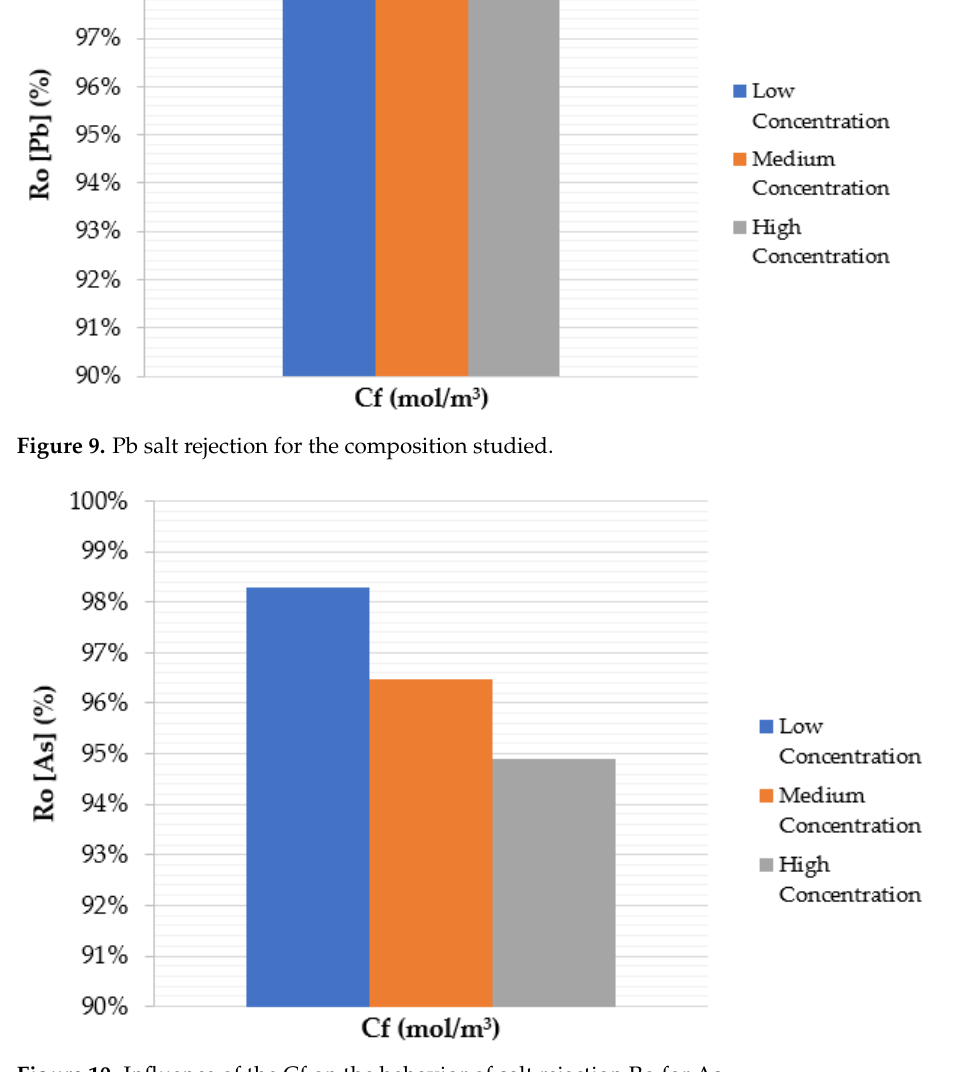
Figure 10. Influence of the Cf on the behavior of salt rejection Ro for As.